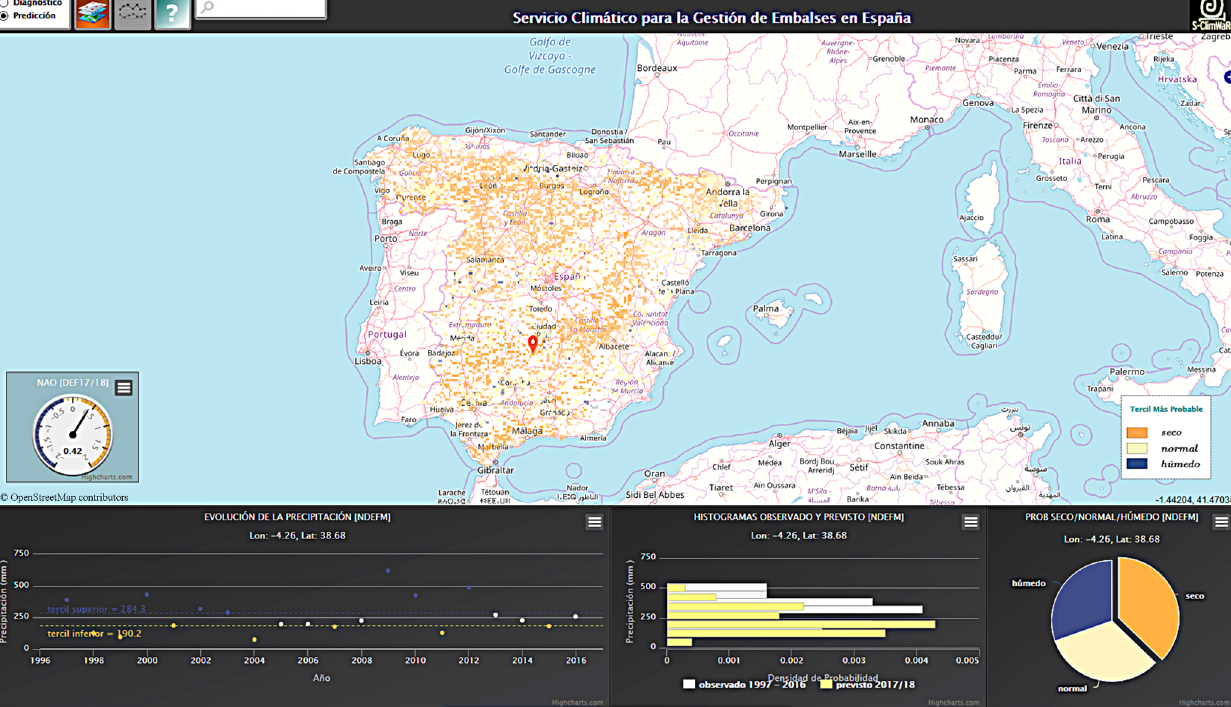
Figure 5. Forecasting view. It displays spatial distribution of the winter precipitation seasonal prediction, the forecasted winter DJF NAO, and different graphics concerning the precipitation or water reservoir inflow prediction at the selected geographical location. © OpenStreetMap contributors 2019. Distributed under a Creative Commons BY-SA